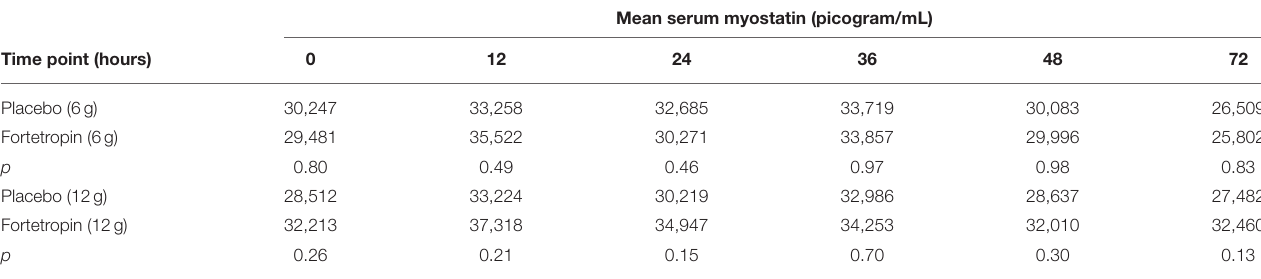
TABLE 1 | Mean serum myostatin (pg/mL) by time point for low- and high-dose Fortetropin groups compared to high- and low-dose placebo groups.